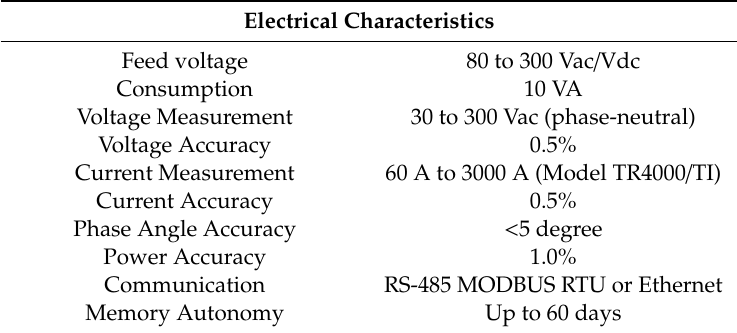
Table 4. Specifications of Smart Meters Connected to SISGEE.